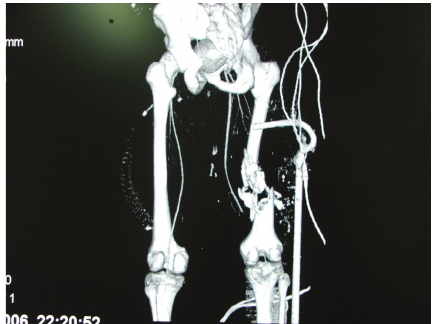
F 3: ree dimensional reconstruction of CTA demonstrating a le super�cial femoral artery (injury) with a comminuted fracture. Note that aer utilizing master cut and vessel extraction the splint does not interfere.